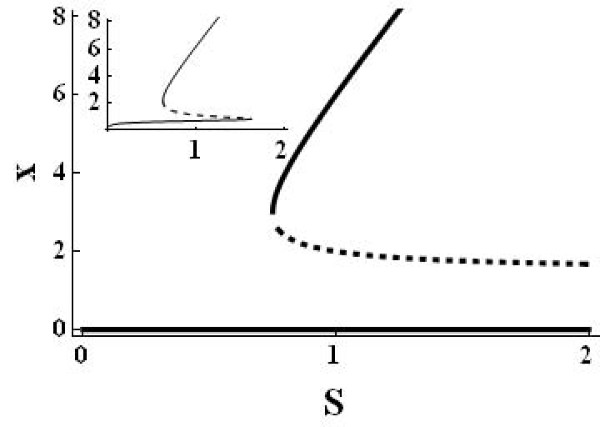
Signal-response curve (bifurcation diagram) of system (2) for the parameters k1 = 8, k2 = 1, k3 = 1, k4 = 1.5. Solid lines indicate locally stable steady states, the dashed line locally unstable steady states. The inset shows the signal-response curve if an additional small constant influx into X (here 0.6) is assumed (enabling a positive 'off' state, leaving the 'on' state and bifurcation point nearly unchanged). This is the classical toggle switch (terminology of Tyson et al. (6), others use the term toggle switch to describe a double negative (i.e. positive) feedback loop (4)) picture enabling the hysteresis cycle: starting with low values and increasing the signal continuously increases the response, until the saddle-node bifurcation at about S = 1.7 is reached. Further increase of the signal leads to a sudden jump of the response to the upper steady state. Decreasing the signal now leads to a continuous decrease of the response, the systems stays in the upper steady state until the left bifurcation point is reached where the response jumps back to the lower steady state.